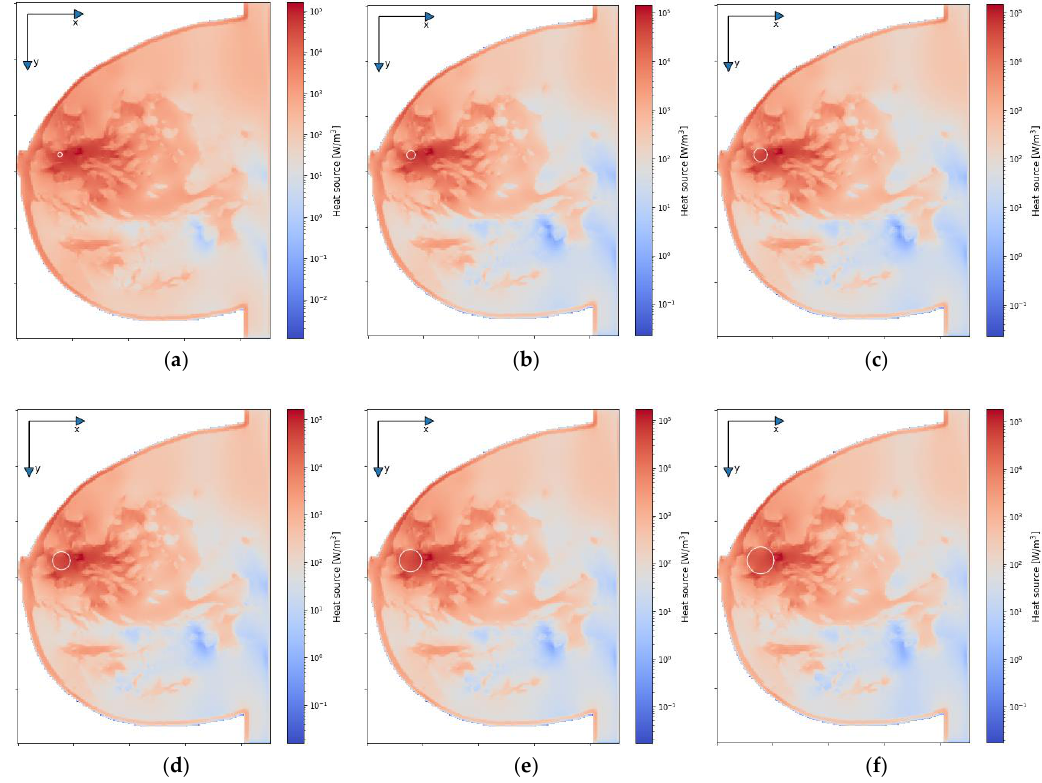
Figure 7. The distributions of power dissipation ( Q = ρ SAR) in the xy plane for various tumor radii: ( a ) r = 2 mm; ( b ) r = 4 mm; ( c ) r = 6 mm; ( d ) r = 8 mm; ( e ) r = 10 mm; ( f ) r = 12 mm—derived from the eight-dipole antenna array after the optimization procedure (sum P i = 8W).